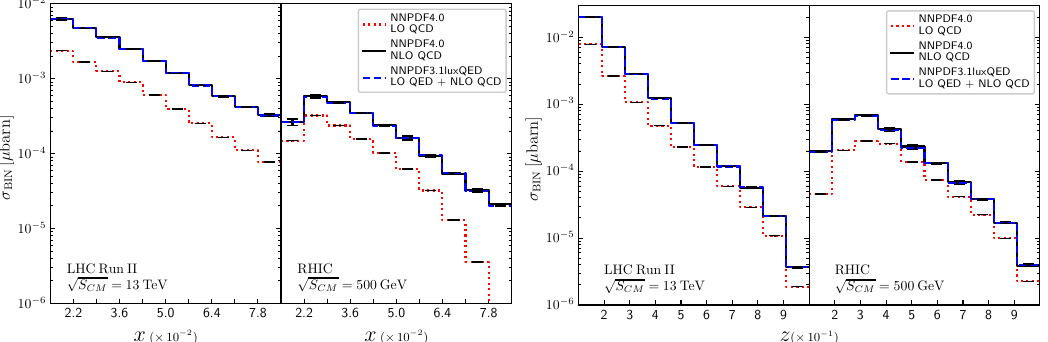
Figure 4: Cross-section as a function of the partonic momentum fractions x (left) and z (right), for RHIC and LHC Run II . Since these experiments involve p + p collisions, we consider x = x as given by Eq. 1